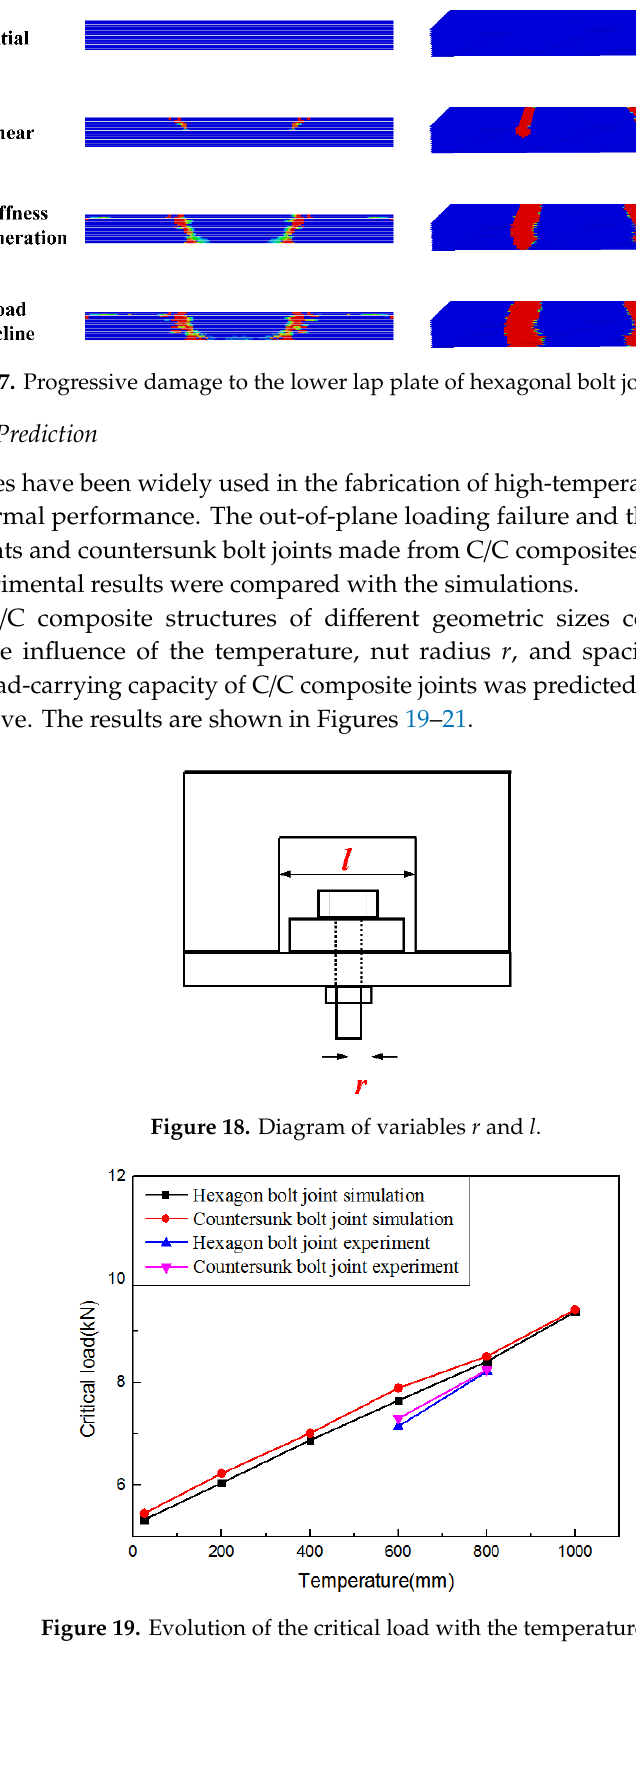
Figure 20. Evolution of the critical load with the radius of the nut r . Figure 21. Evolution of the critical load with the distance d. 4. Conclusions In this study, the failure mechanisms and damage evolution of metallic hexagonal head bolt joints and metallic countersunk head bolt joints made from C/C composites experiencing out-of-plane loads at 600 and 800 °C were investigated experimentally and by finite element simulations. The dominant failure modes were determined, the damaged areas were observed using a microscope,